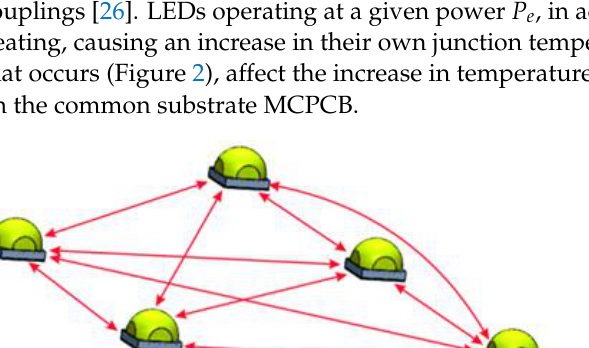
Figure 2. Thermal mutual coupling between LEDs.